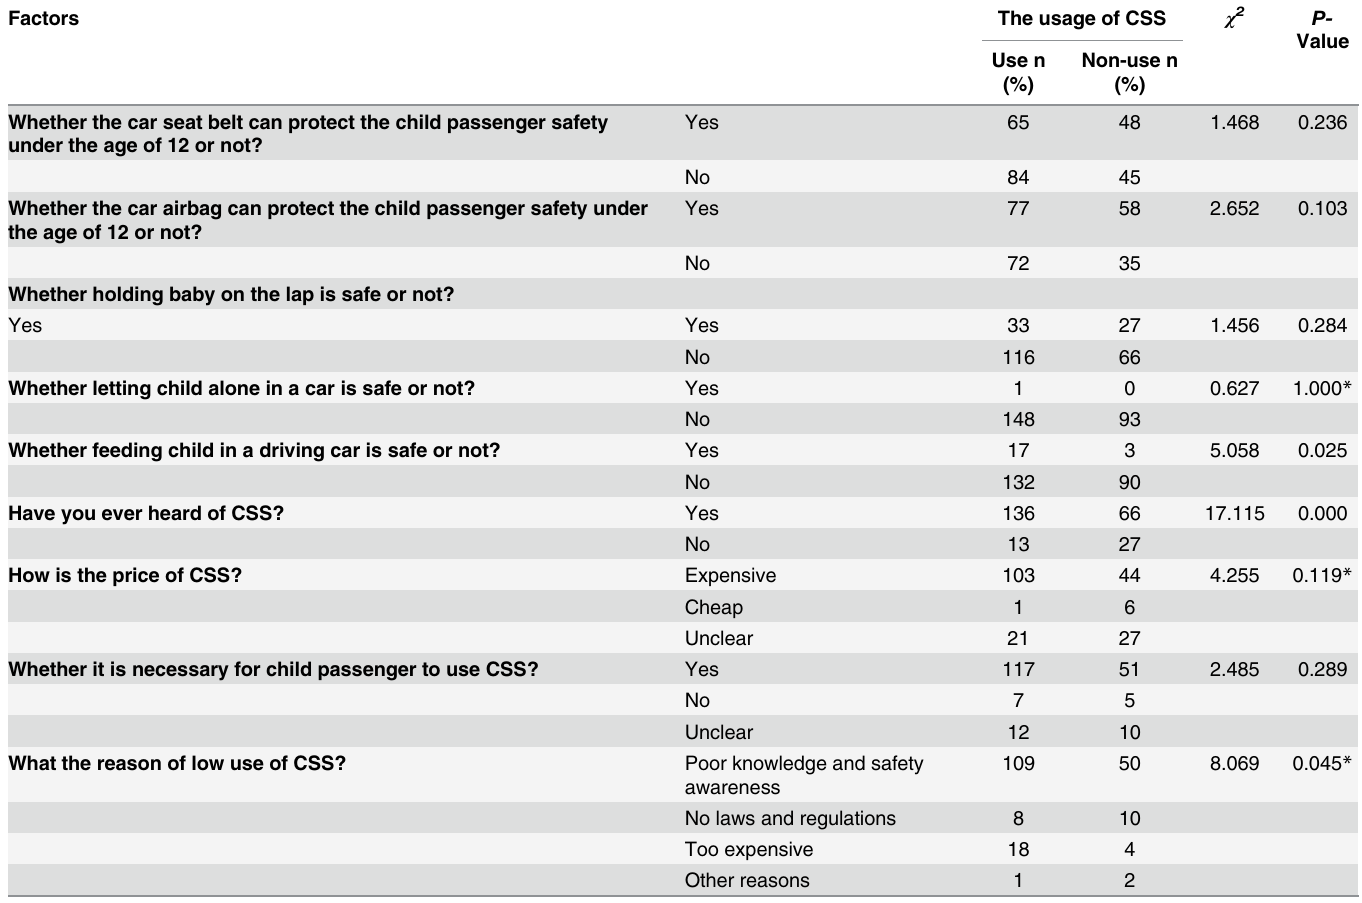
Table 2. Attitudes and Knowledge on CPS of Surveyed Newborn